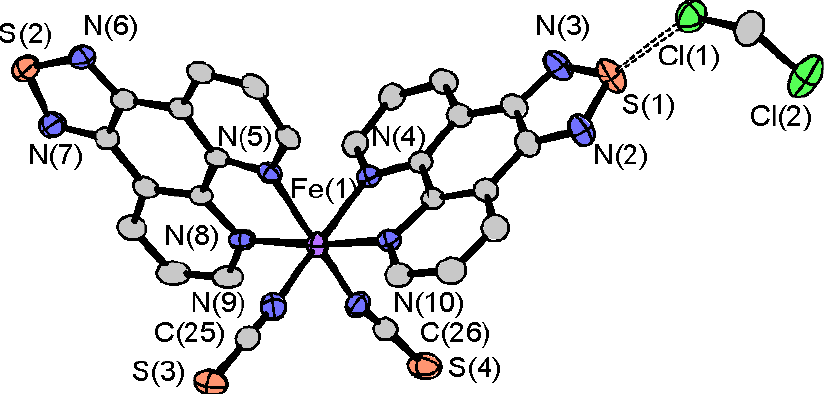
Figure 9. Intermolecular interaction in [Fe(tdap) permission of The Royal Society of